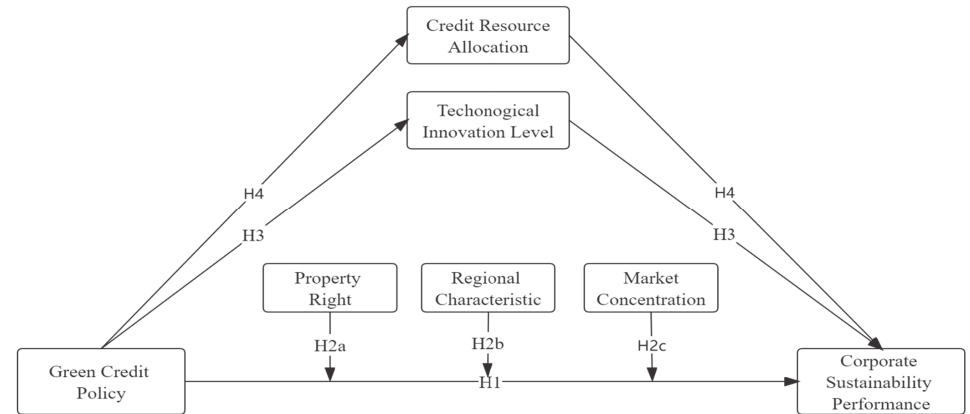
Figure 1. Conceptual model. Figure 1.